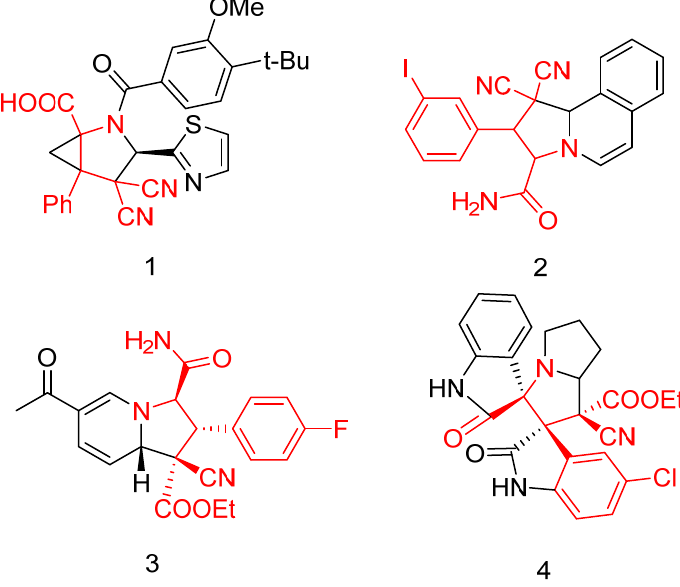
Figure 1. Structures of some biologically important compounds containing α -amino- β - substituted γ , γ - disubstituted butyric acid